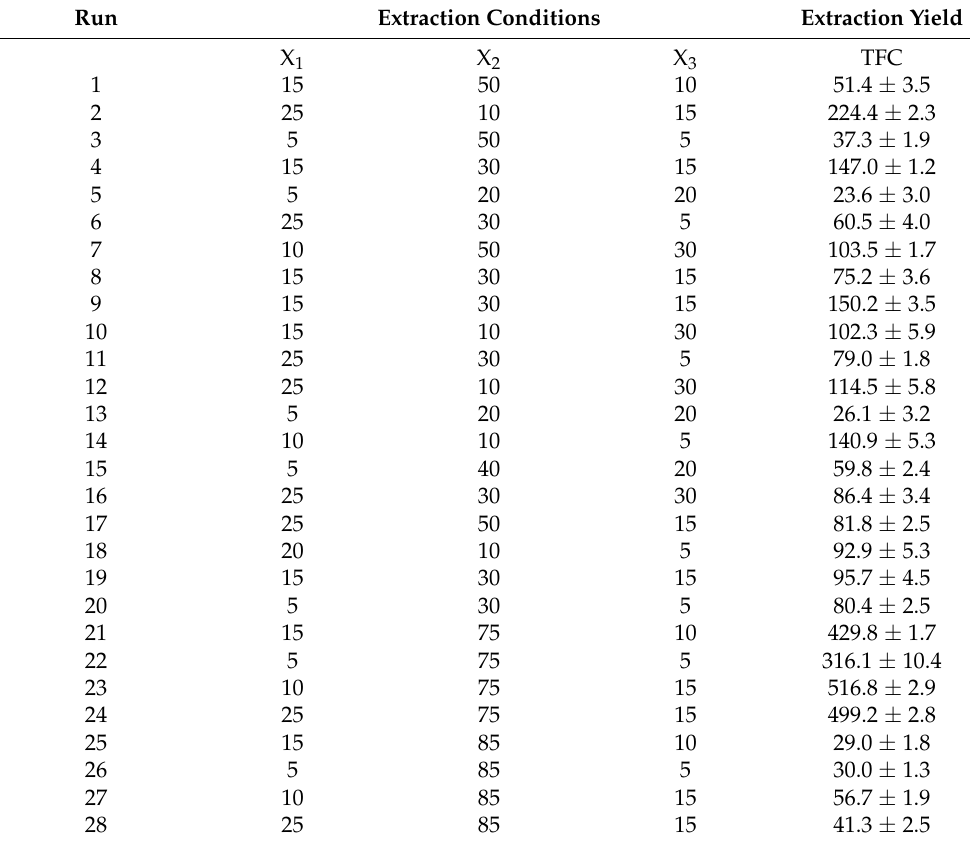
Table 3. Box–Behnken design with the independent variables and responses data.